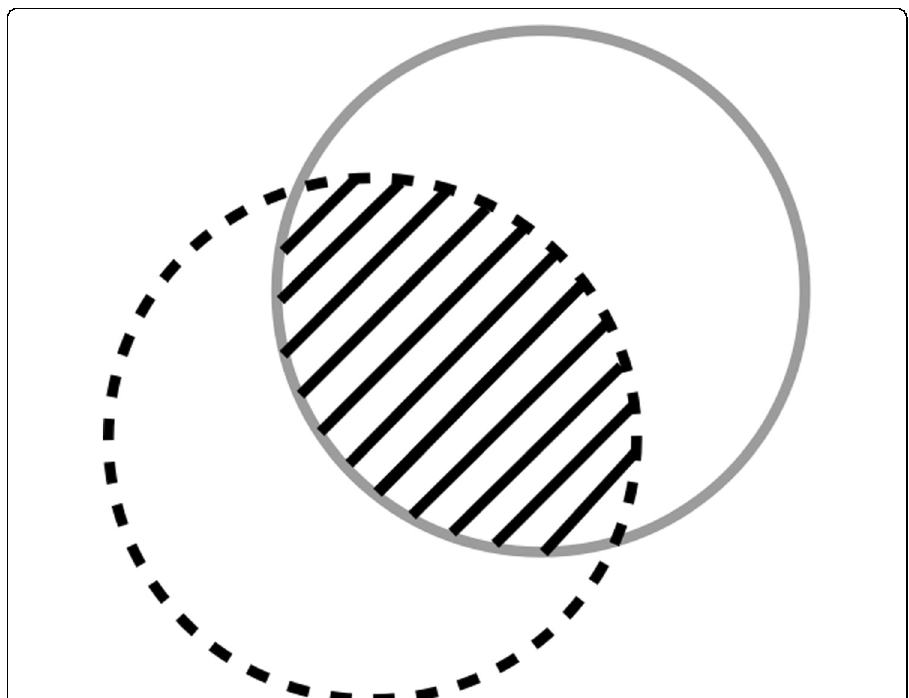
Fig. 17 Legend: The porosity of EMMAs circle indicates her ‘ openness ’ to foreign platform models, and the grey circle and the diagonal lines indicate the conflation with non-European platforms